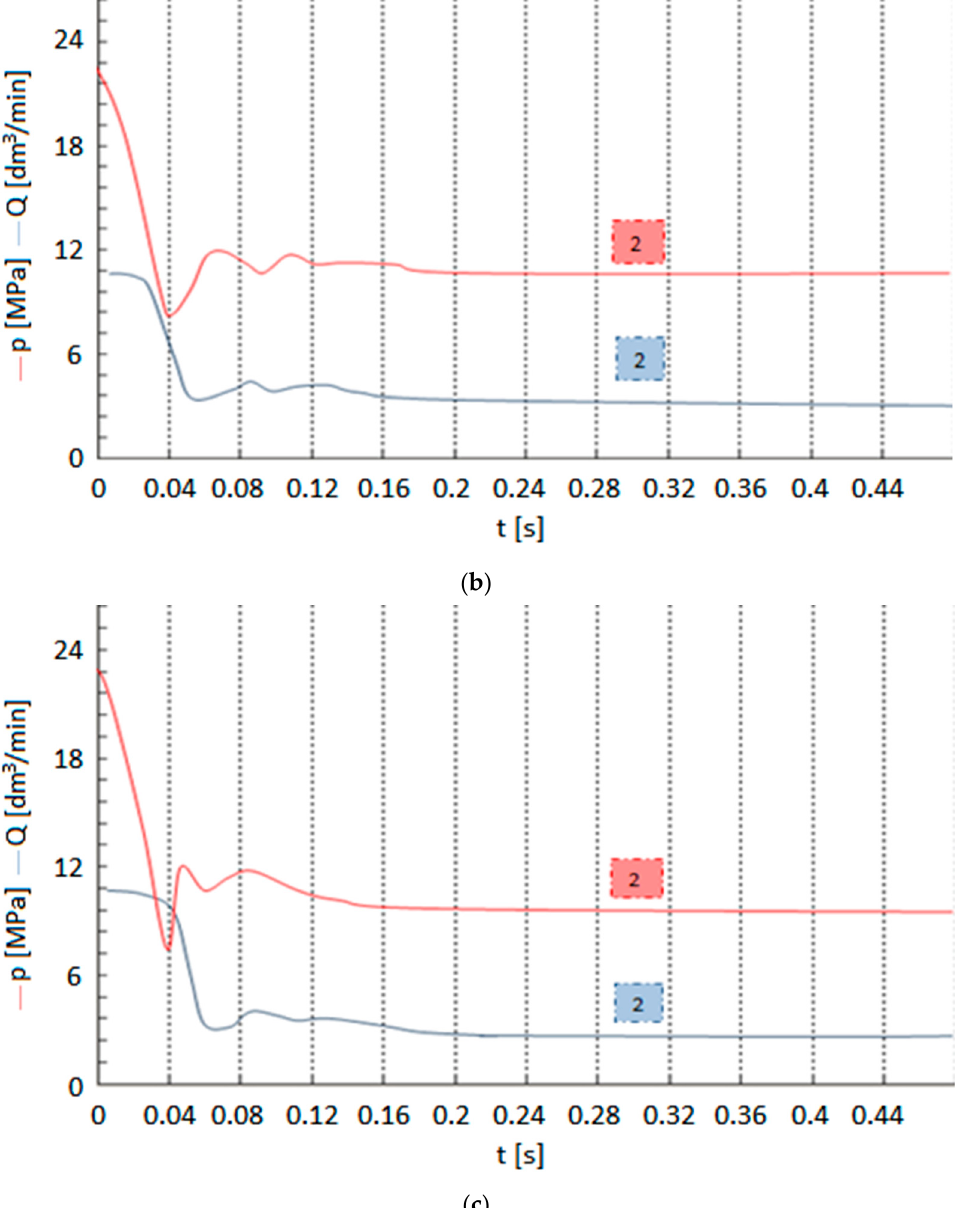
Figure 9. The Q and p time periods for code changes of the K p1 ·K p2 , Q rz , and F m parameters where Q rz : ( a ) 2(212), ( b ) 2(211), and ( c ) 2(210). Runs for a weighting factor value of w i = 2.